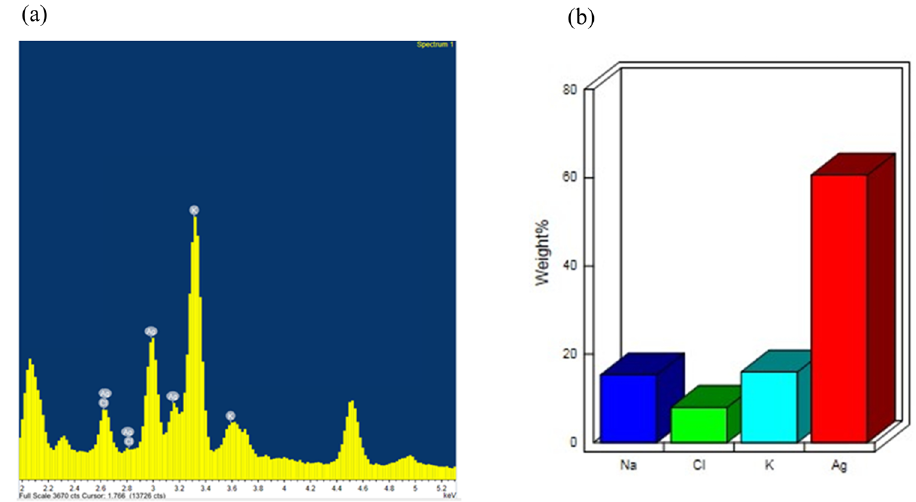
Figure 4: EDX elemental analysis of green - synthesized M. oleifera – AgNPs: ( a ) peaks visible on spectra, and ( b ) quantitative